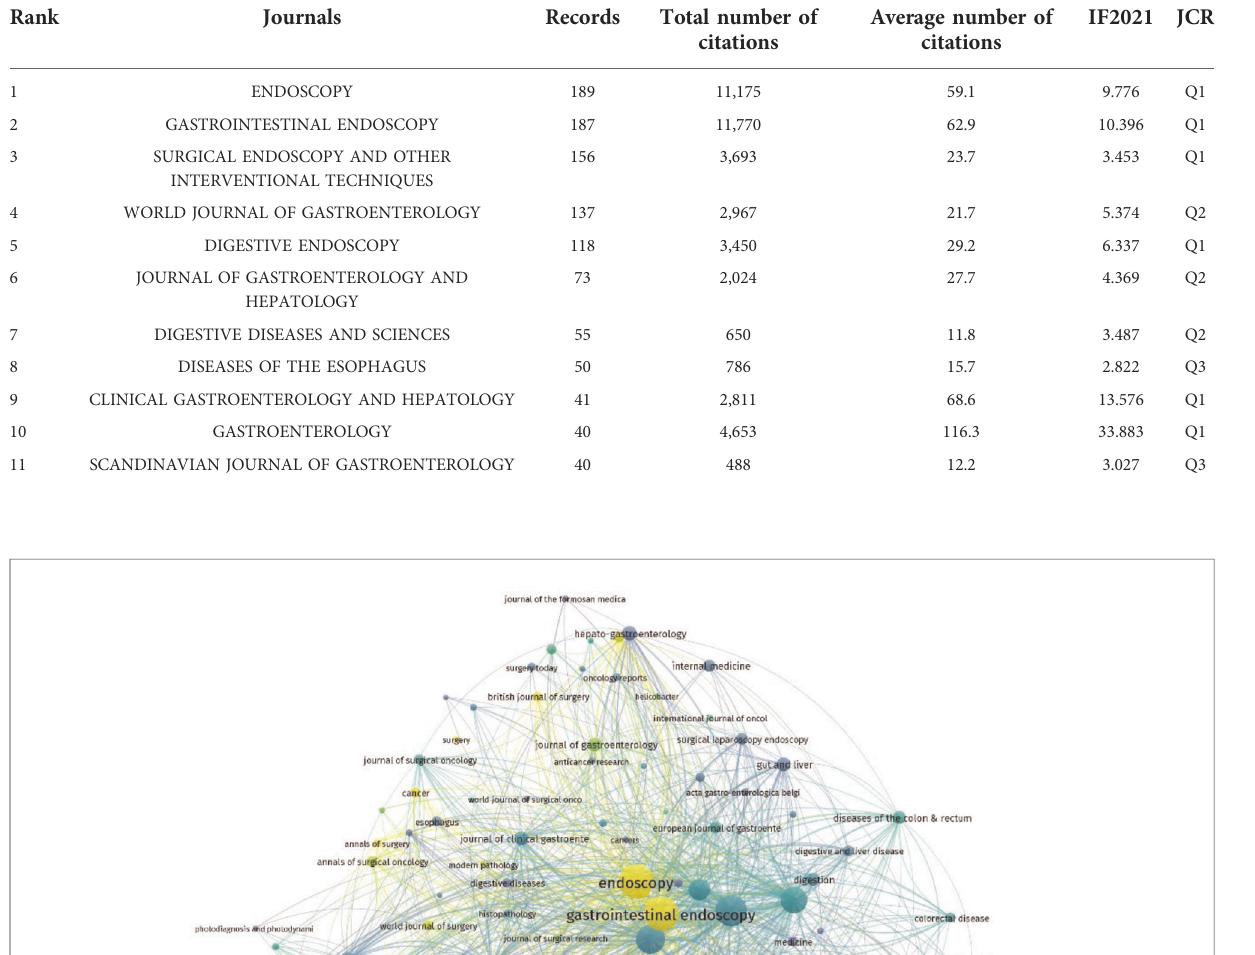
TABLE 5 Top 11 journals in terms of publications.